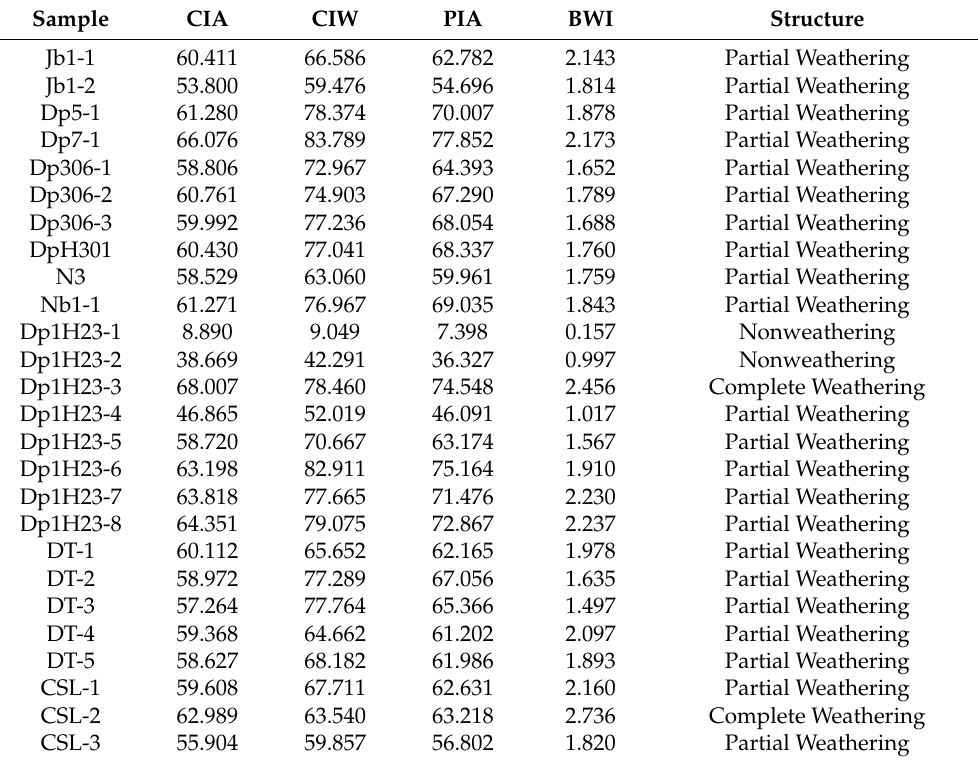
Table 2. Identification of weathering crust structure using weathering